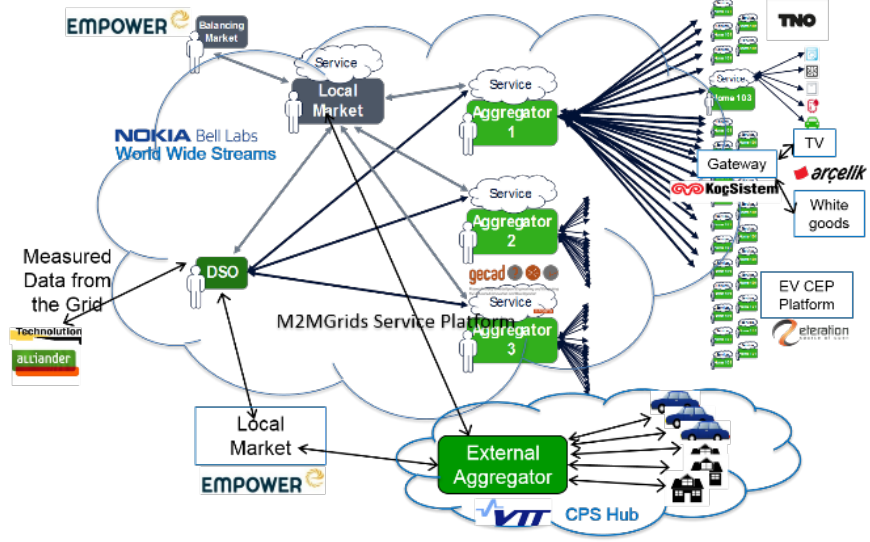
Figure 25. Structure of the energy flexibility case. DSO, distribution service operator. EV CEP, complex event processing in the electric vehicle.